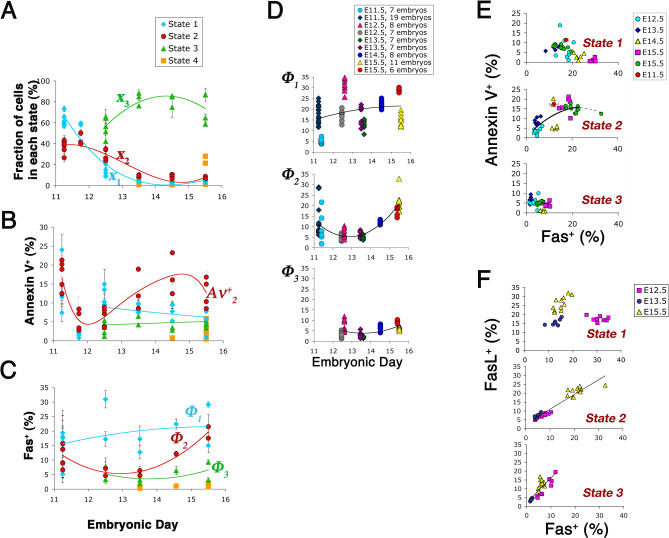
Fraction of Cells Expressing FAS or FASL or Binding ANXA5 during E11–E15.5(A and B) ANXA5 binding in each of the four fetal liver states (B) and the corresponding frequency of each state in the same fetal livers (A) during E11–E15.5. Each data point is the mean ± standard error of the mean for embryos in one litter. x
1, x
2, and x
3 are the fraction of cells in states 1, 2, and 3, respectively. Av+
2 is the fraction of cells in state 2 that bind ANXA5. Individual embryo data for the same dataset are presented in Protocol S2, section 2.3.(C and D) The fraction of cells expressing FAS in each state during E11–E15.5. Each data point in (C) is mean ± standard deviation for a litter of embryos. Individual embryos in the same dataset are shown in (D); each symbol denotes an independent experiment of one or more litters from the same embryonic age. Further analysis of embryos in this dataset, with the same symbols, is shown in Figure 6A and 6F. Φ1, Φ2, and Φ3 are the fraction of cells expressing FAS in states 1, 2, and 3, respectively. All curves are second-order polynomials. In order to avoid overlapping data points in (D), the data for some litters were slightly displaced along the horizontal axis (e.g., E13.5 was plotted as E13.45).(E) Fraction of cells that are ANXA5+ and FAS+ in states 1 to 3, measured in the same fetal livers (E12.5–E15.5) or in the same litters (E11.5, due to the small number of cells in fetal liver at this age). Each point represents a single embryo (E12.5–E15.5) or a single experiment (E11.5, mean of four litters). Each symbol denotes an independent experiment of one or more litters. Curve is a second-order polynomial.(F) Fraction of cells that are FASL+ and FAS+ in states 1 to 3, measured in the same fetal livers (E12.5–E15.5). Each color denotes an independent experiment of one or more litters.